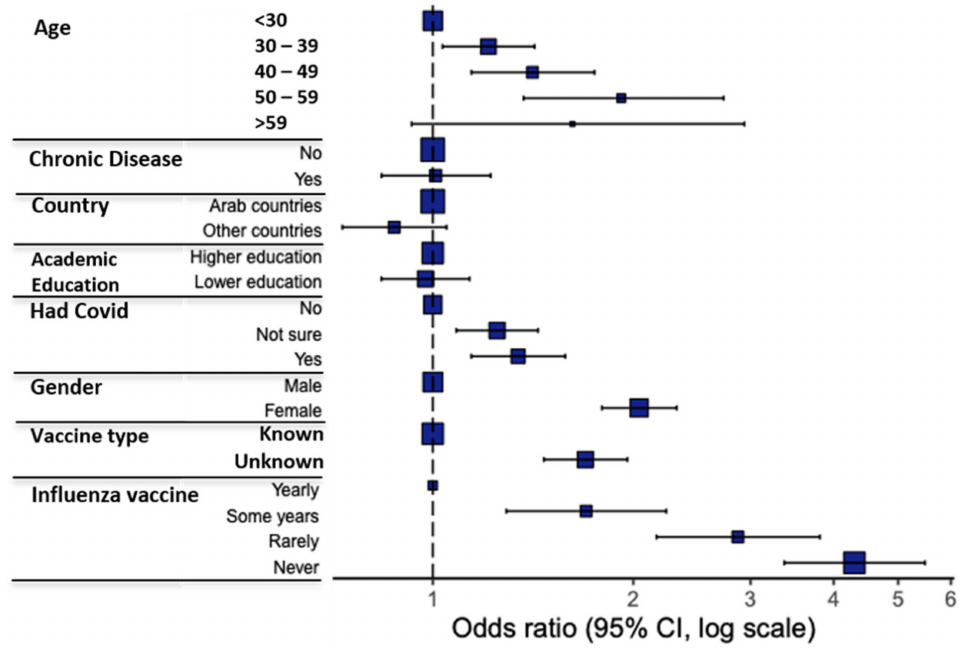
Figure 3. Multivariate analysis results of COVID-19 vaccine acceptance/hesitancy stratified according to different factors; odds ratio (OR) and 95% confidence intervals (CI) are shown; the size of the box represents the number of participants in each